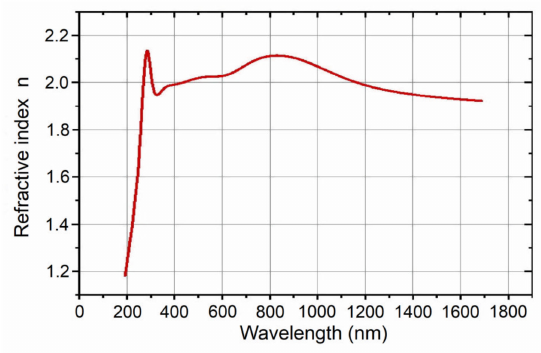
Figure 8. Refractive index of WO 3 film, thickness 40 nm.